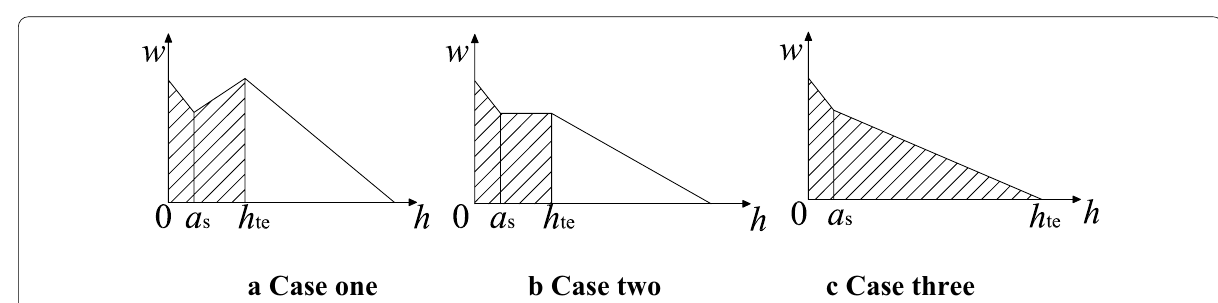
Fig. 10 Determination of the effective tensile depth h te based on the test results.